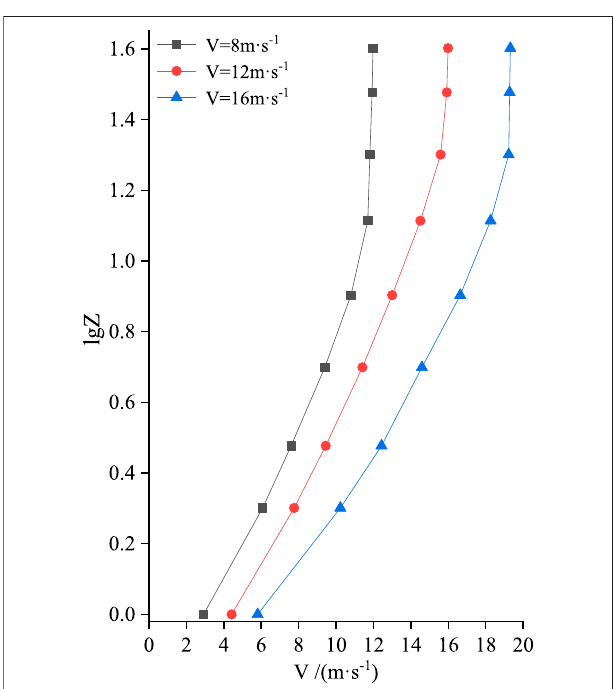
FIGURE 4 | The change law of the wind velocity pro fi le of the cavity under different test wind